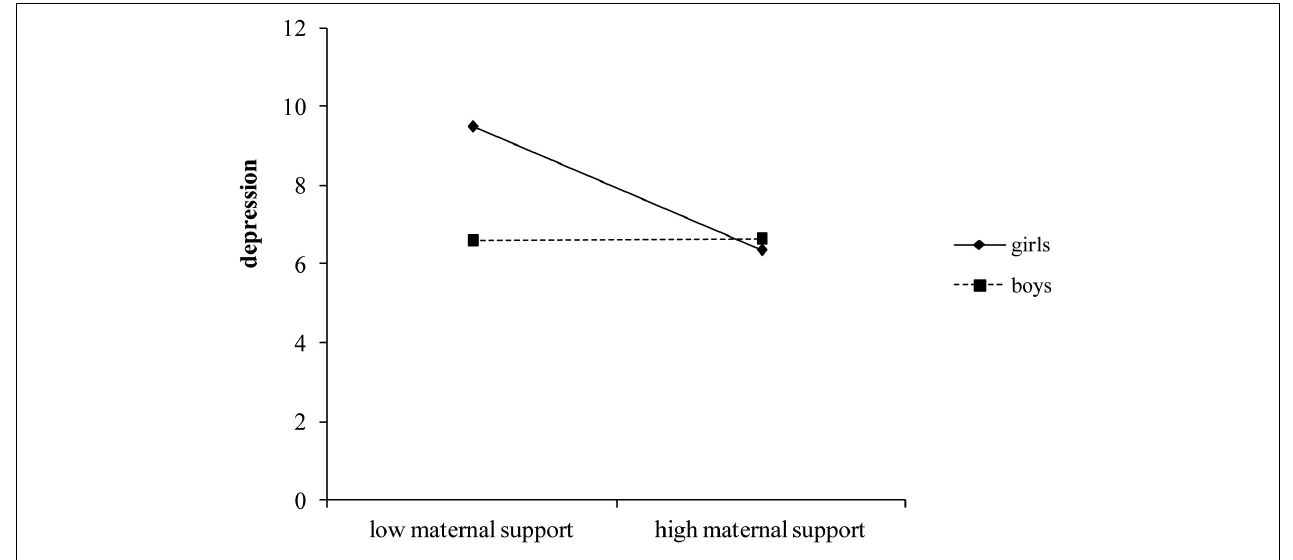
FIGURE 3 | Moderating effect of gender on the relationship between maternal support and depression (controlling for cognitive